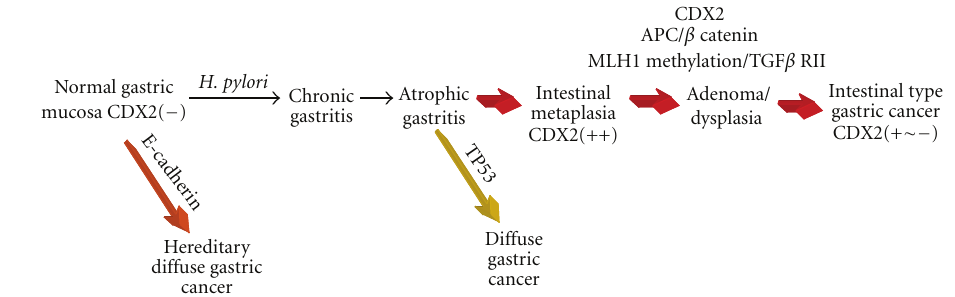
Figure 1: Correa model for intestinal type GC.